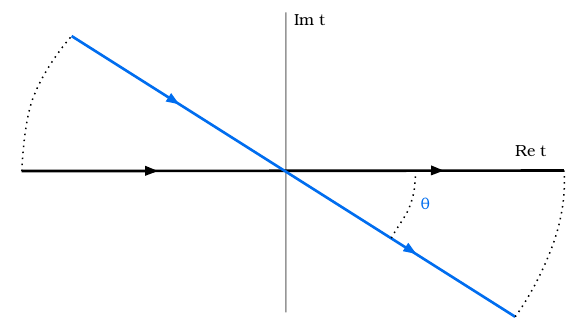
Figure 2 . Time contour rotated by an arbitrary angle (cid:18)